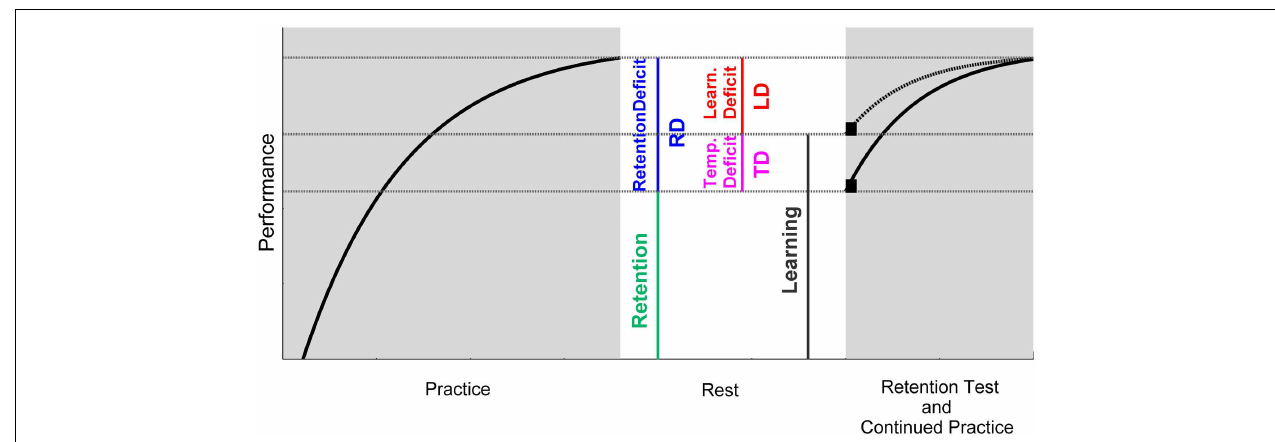
deficits need to be taken into account in order to determine learning. If temporary deficits could be eliminated, retention performance would be higher as compared to when temporary deficits became effective (compare the black squares after rest). And this performance would represent what would have been learned. Since temporary effects vanish with further practice, performance curves of both scenarios merge after some practice trials (compare dashed and solid line after rest).